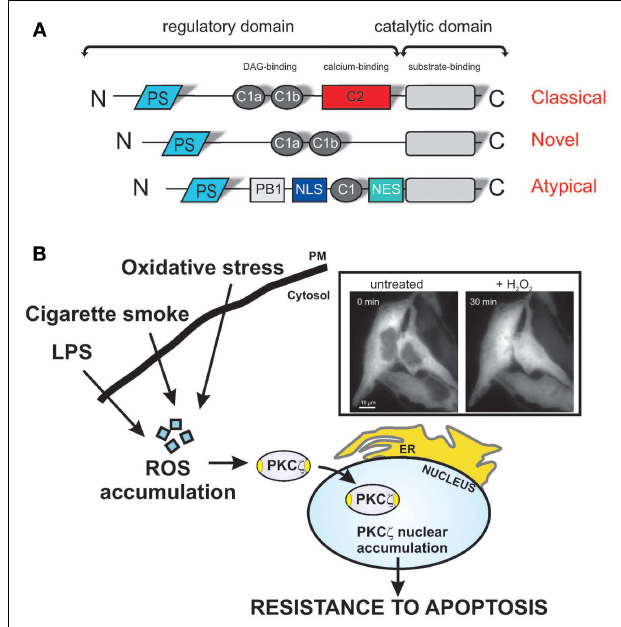
FIGURE 1 | Redox stress induces PKC ζ nuclear translocation, protecting cells via various apoptotic stimuli . (A) Schematic model of PKC structure. Representation of the different PKC subfamilies and their structural domains.The pseudo-substrate (PS) domain blocks the substrate-binding cavity of the kinase domain as an autoinhibitory mechanism. Conserved region 1 (C1) confers binding to diacylglycerol (DAG) and phospholipids, and C2 senses calcium.The PB1 and NLS/NES domains are specific for atypical PKCs and act as a protein-binding domain and nuclear import-system domain, respectively. (B) Shows representative images of chimeric PKC ζ GFP-expressing HeLa cells in the resting condition (untreated) and after a 30-min treatment with 1mM H 2 O 2 . PKC ζ localizes uniformly throughout the cytoplasm and is excluded from the nucleus, but upon oxidative stress challenge, the kinase translocates to the nucleus. Stress conditions, such the presence of as bacterial infection or cigarette smoke, favor the accumulation of intracellular ROS, and nuclear redistribution of the ζ isoform, conferring apoptotic resistance, and thus,